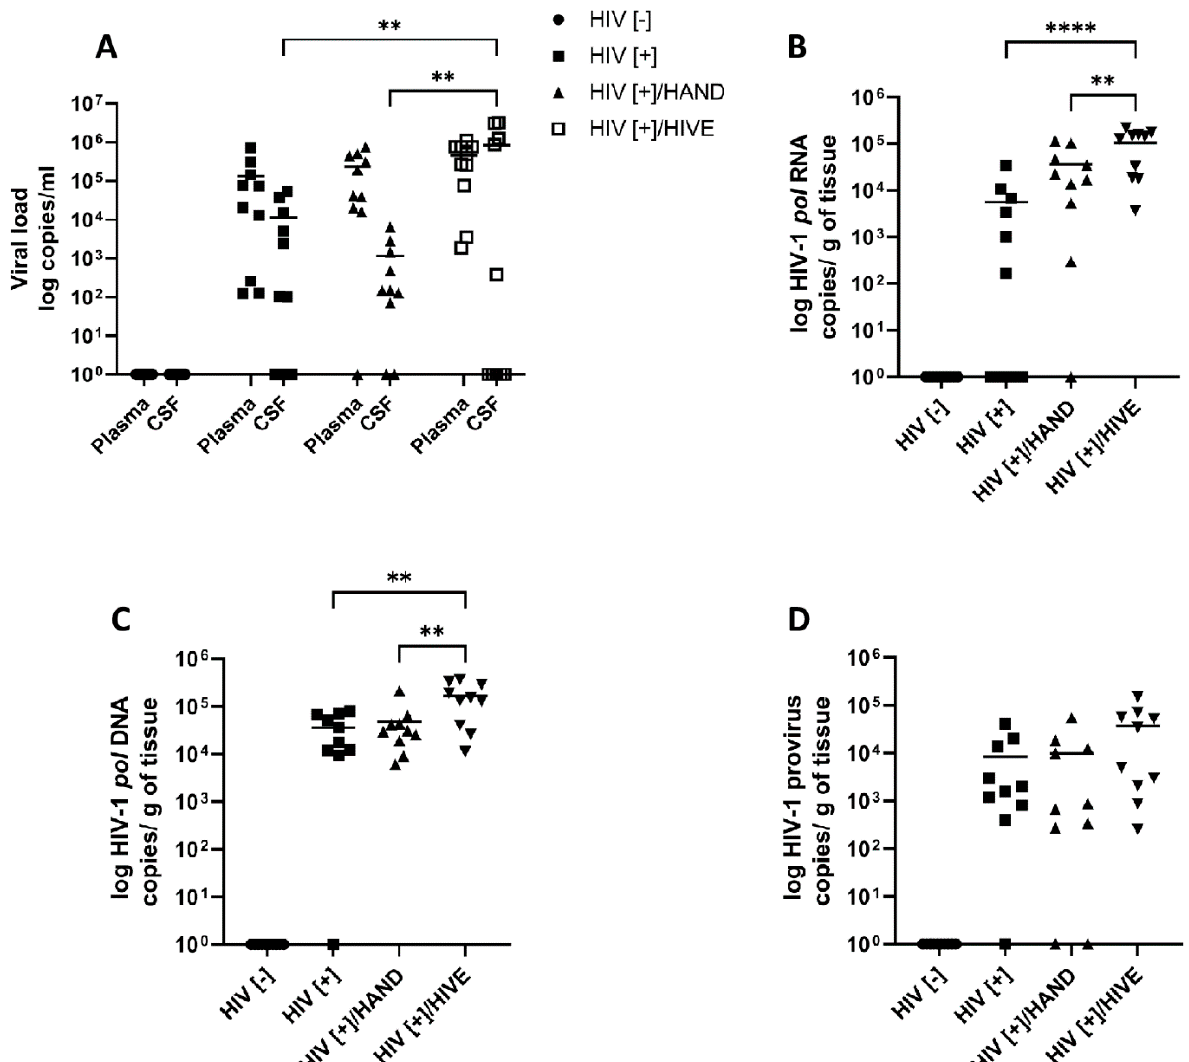
Figure 1. Plasma, CSF and brain viral quantities in the human cohort . Four experimental groups ((HIV[ − ], n = 10), (HIV[+], n = 10), (HIV[+]/HAND, n = 10) and (HIV[+]/HIVE, n = 10)) were examined for plasma and CSF HIV RNA copies/mL ( A ), HIV RNA ( B ), total DNA ( C ) and integrated DNA (D) copies/g of brain tissue. The horizontal lines represent the mean values (** , p < 0.01; **** , p < 0.0001 ).